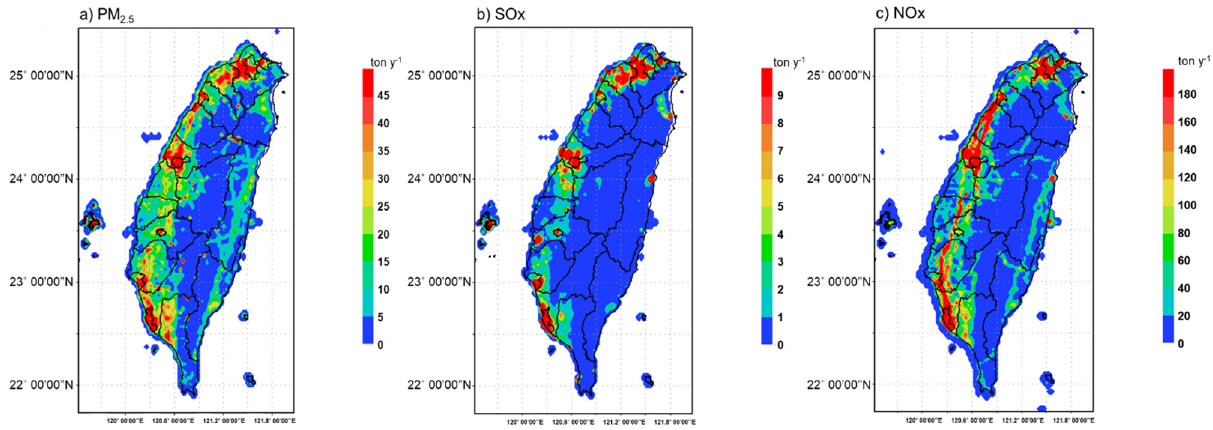
Figure 10. The emission distribution (ton y − 1 ) of PM 2.5 , Sox, and NOx for scenario